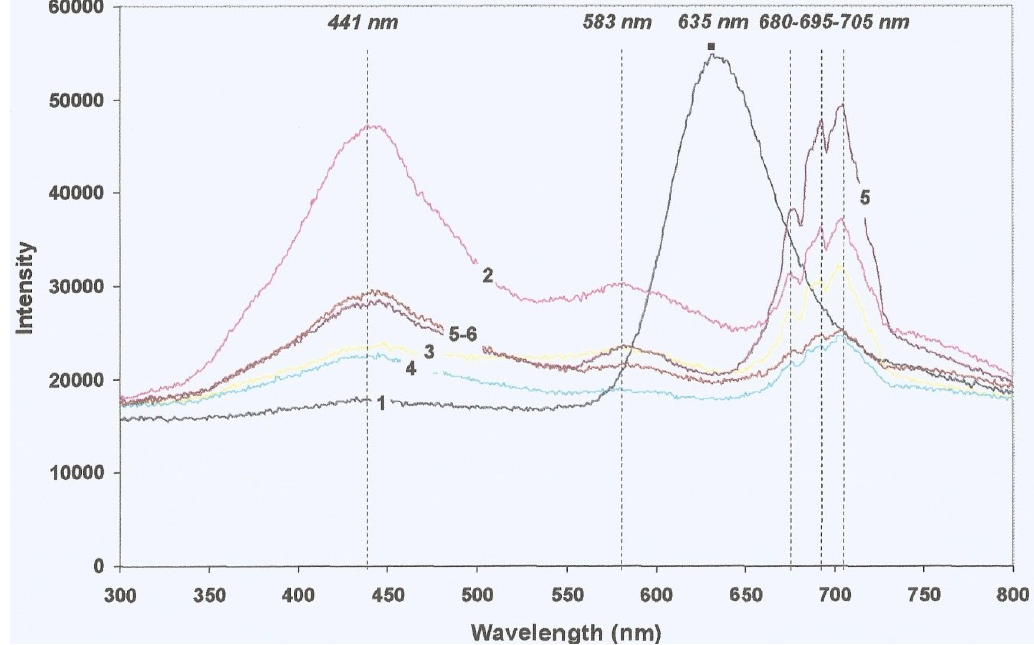
Figure 4. Cathodoluminescence spectral properties of diopside (red region only: 1) and anorthite (blue and red regions: 2-6) from the se- lected area of a Calcium-Aluminium inclusion in Kaba